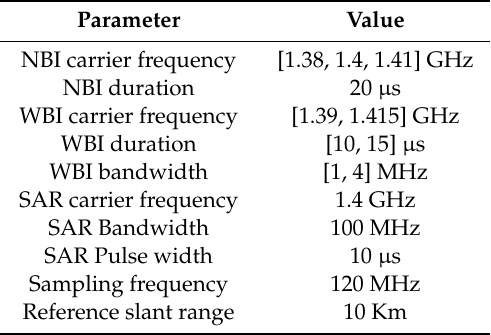
Table 2. Simulation parameters of the